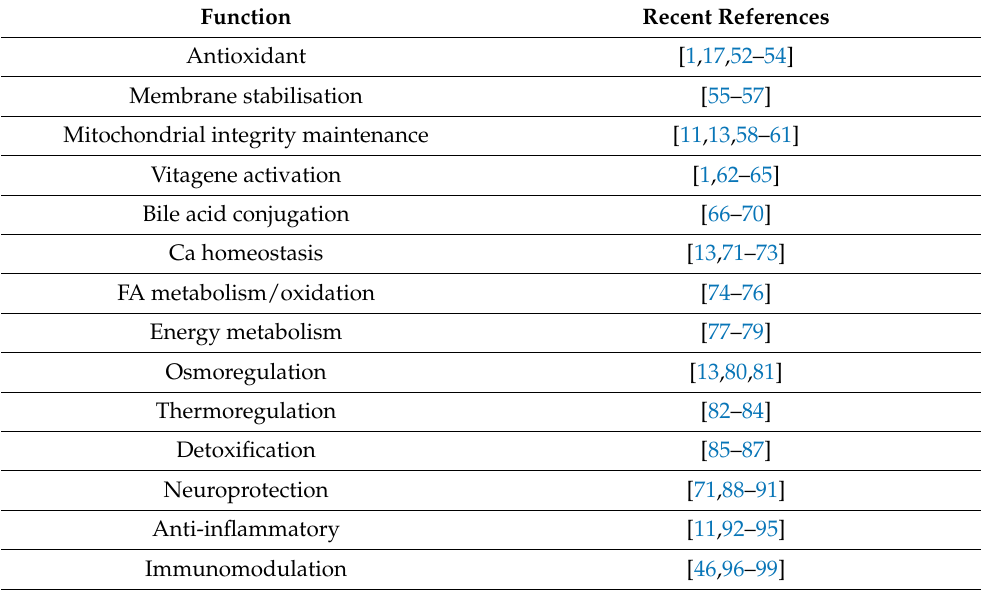
Table 1. Regulatory roles of Tau in biological functions (adapted from